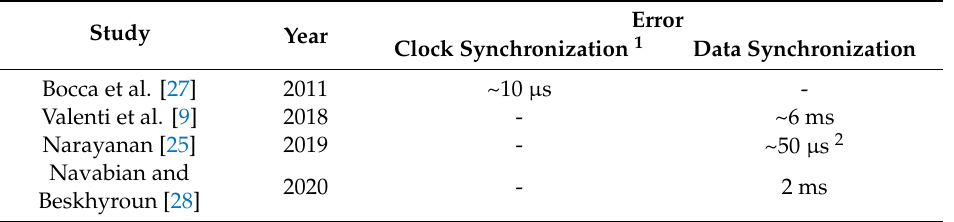
Table 1. Summary of time synchronization error of wireless smart sensors (WSSs) using digital accelerometers.